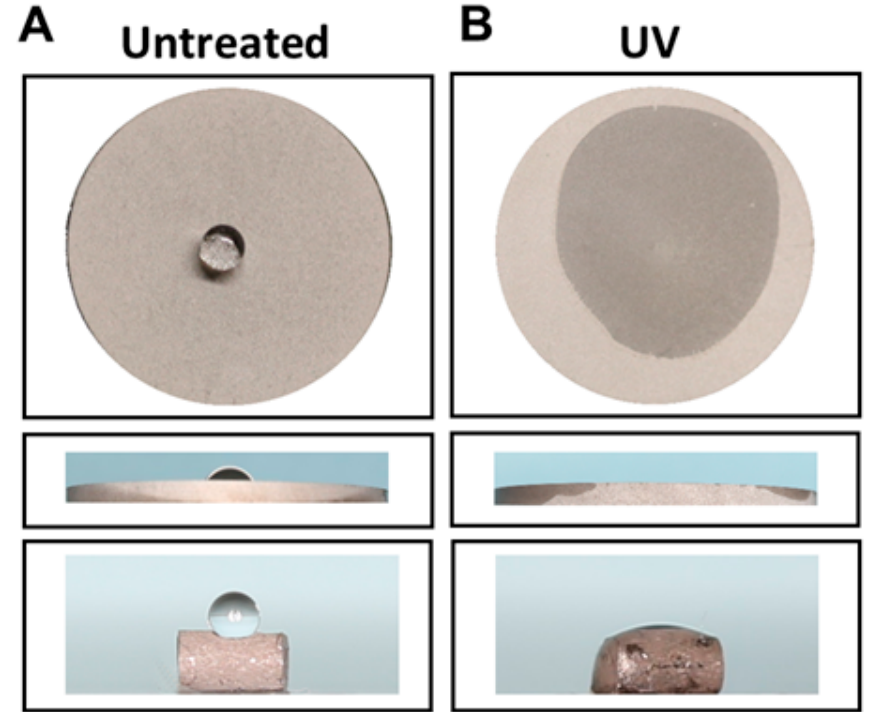
Figure 1. Converted hydrophilicity of acid-etched titanium disk and implant surface. ( A ) Hydrophobic surface of untreated acid-etched disk and implant. ( B ) Hydrophilic surface obtained by photofunctionalization (UV-treated), on which water immediately spread across the surface.